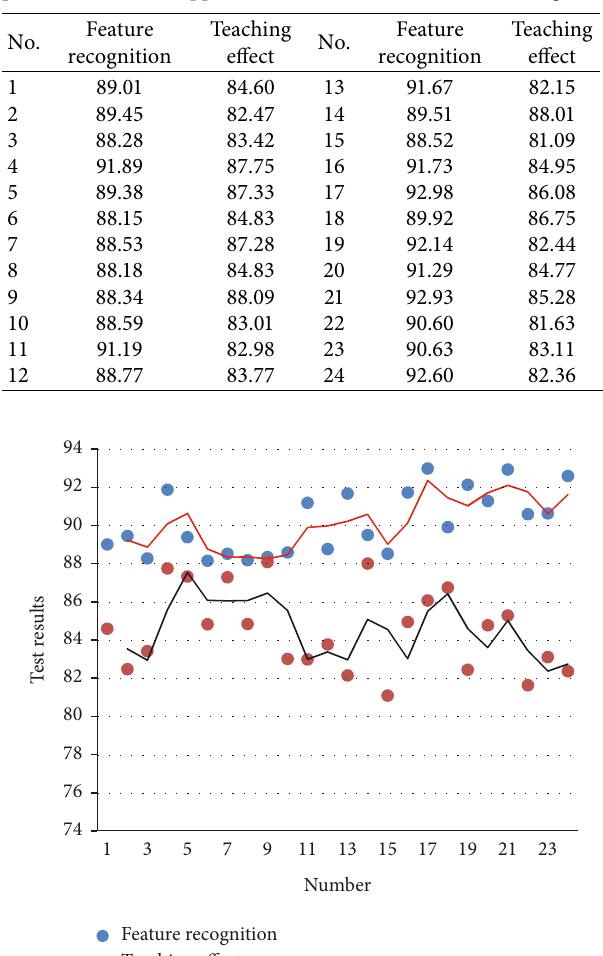
Table 1: The analysis method of computer visualization sound parameters and its application effect in vocal music teaching.